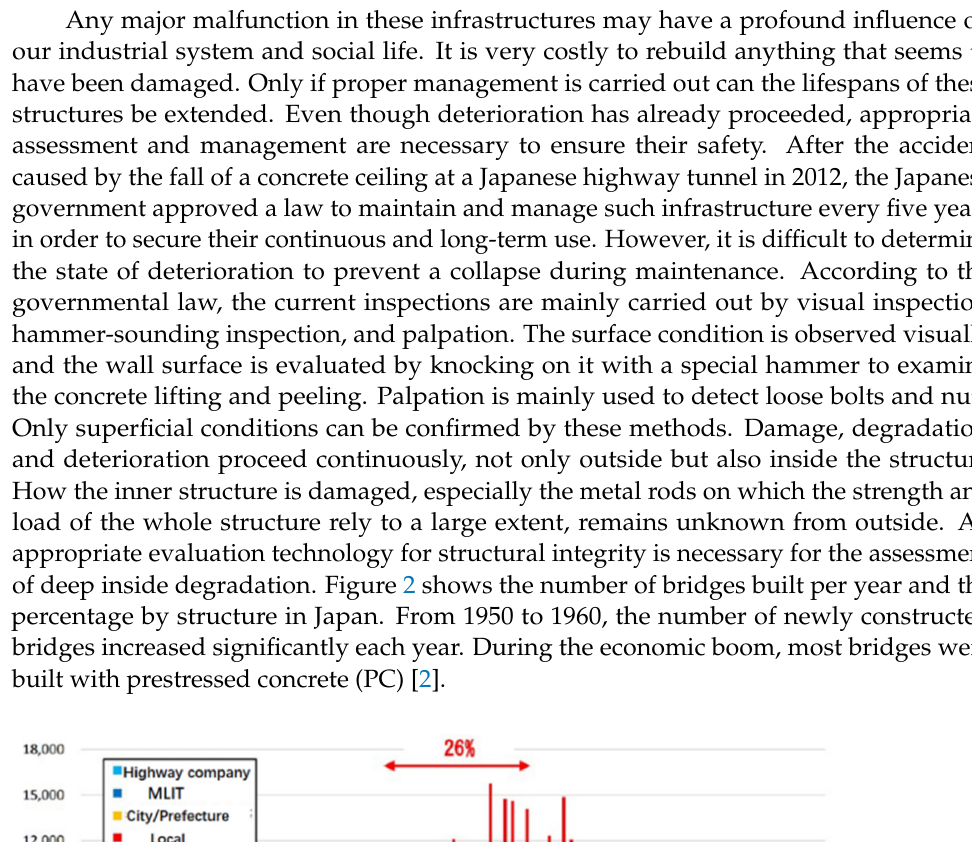
Figure 1. Changes in the ratio of overaged concrete structures in Japan by decade.